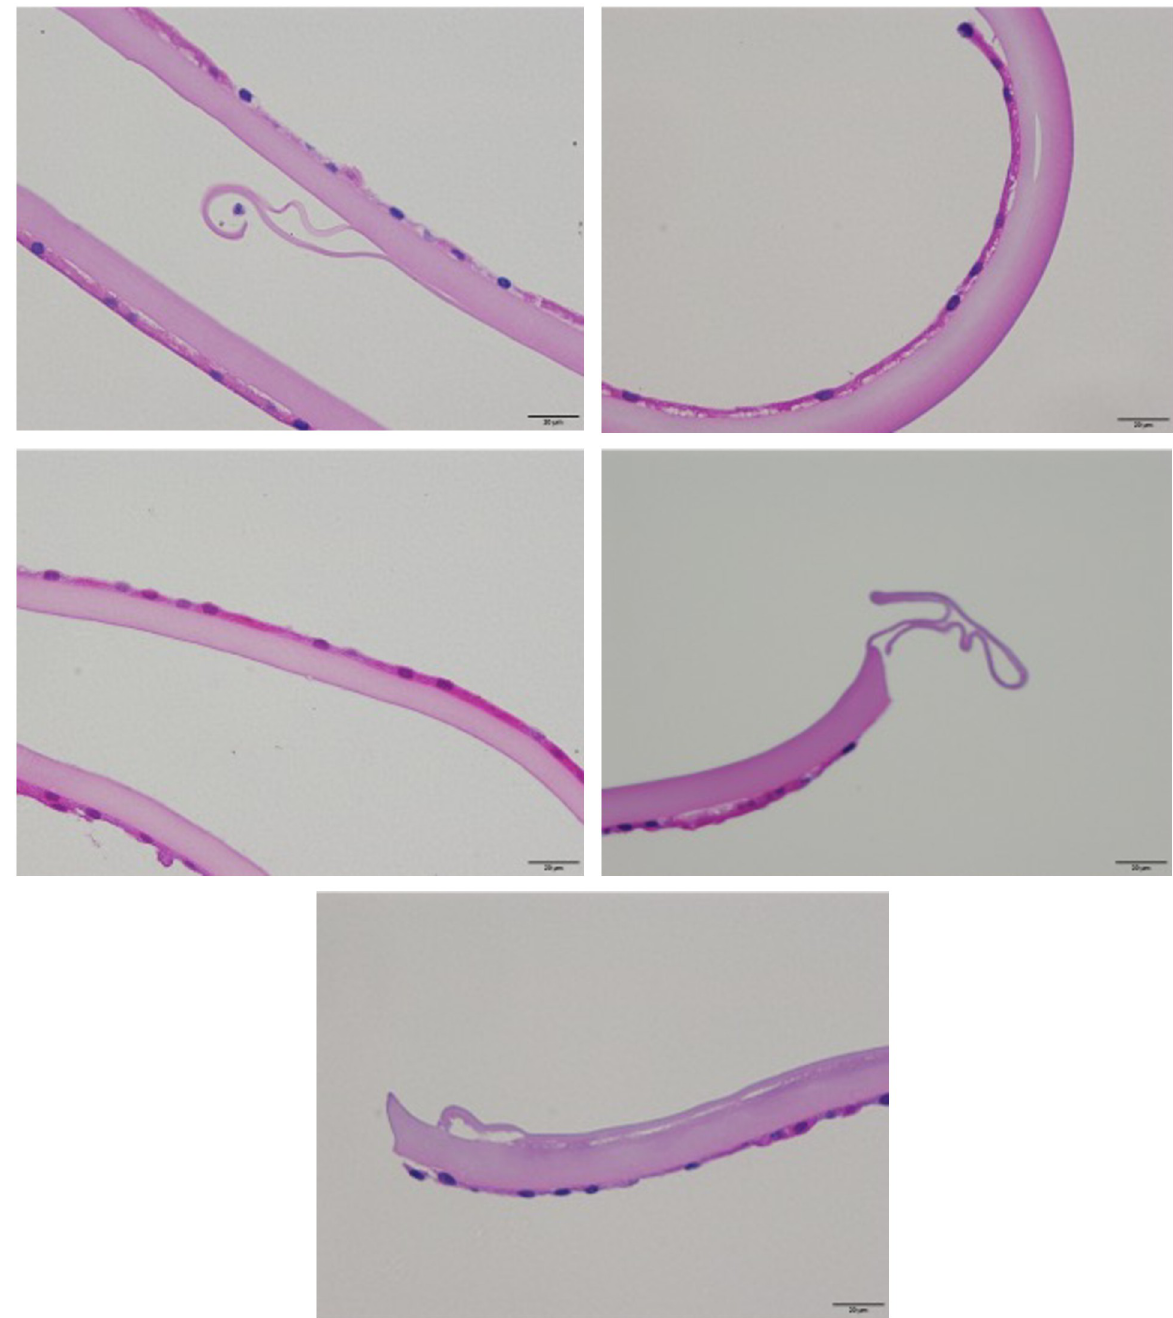
Fig 4. Light microscopic photographs of true exfoliation syndrome. (A) The specimen shows different thickness along the capsule with partial thickness capsular double delamination. (B) The excised capsule shows a space (black arrow) and multiple thin lines (red arrow) within the capsular propia which called capsular lamination. The lens epithelium showed vesicular change. (C) Superficial cyst within anterior lens capsule (D) Tapering edge of the delaminated membrane peripheral to the capsulorhexis with beveled down cut end of capsular propia (E) Vesicular change in the capsule. Coalescence of theses vesicles may progress to capsular